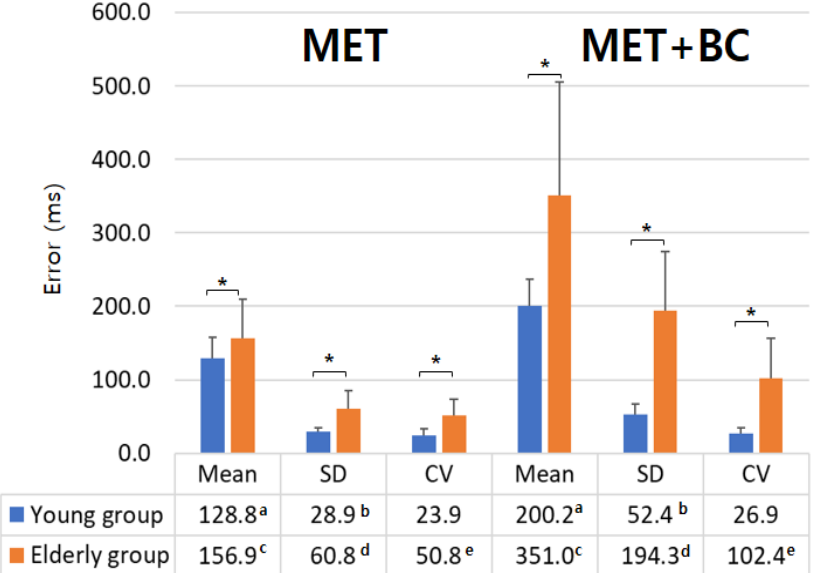
Figure 2. Mean, standard deviation (SD), and coefficient of variance (CV) of temporal errors between the metronome beat and the heel contact for each gait condition by age (*: Statistical difference between age groups by variable, a, b, c, d, e: Statistical difference by gait condition in each group; MET: walking with the metronome, MET + BC: walking with the metronome while counting backwards).